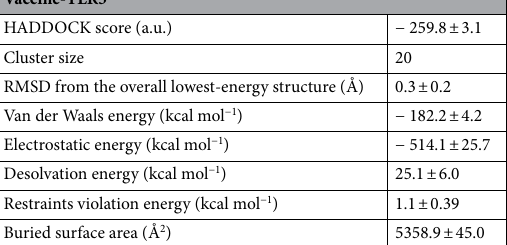
Vaccine-TLR5 HADDOCK score (a.u.) − 259.8 ±